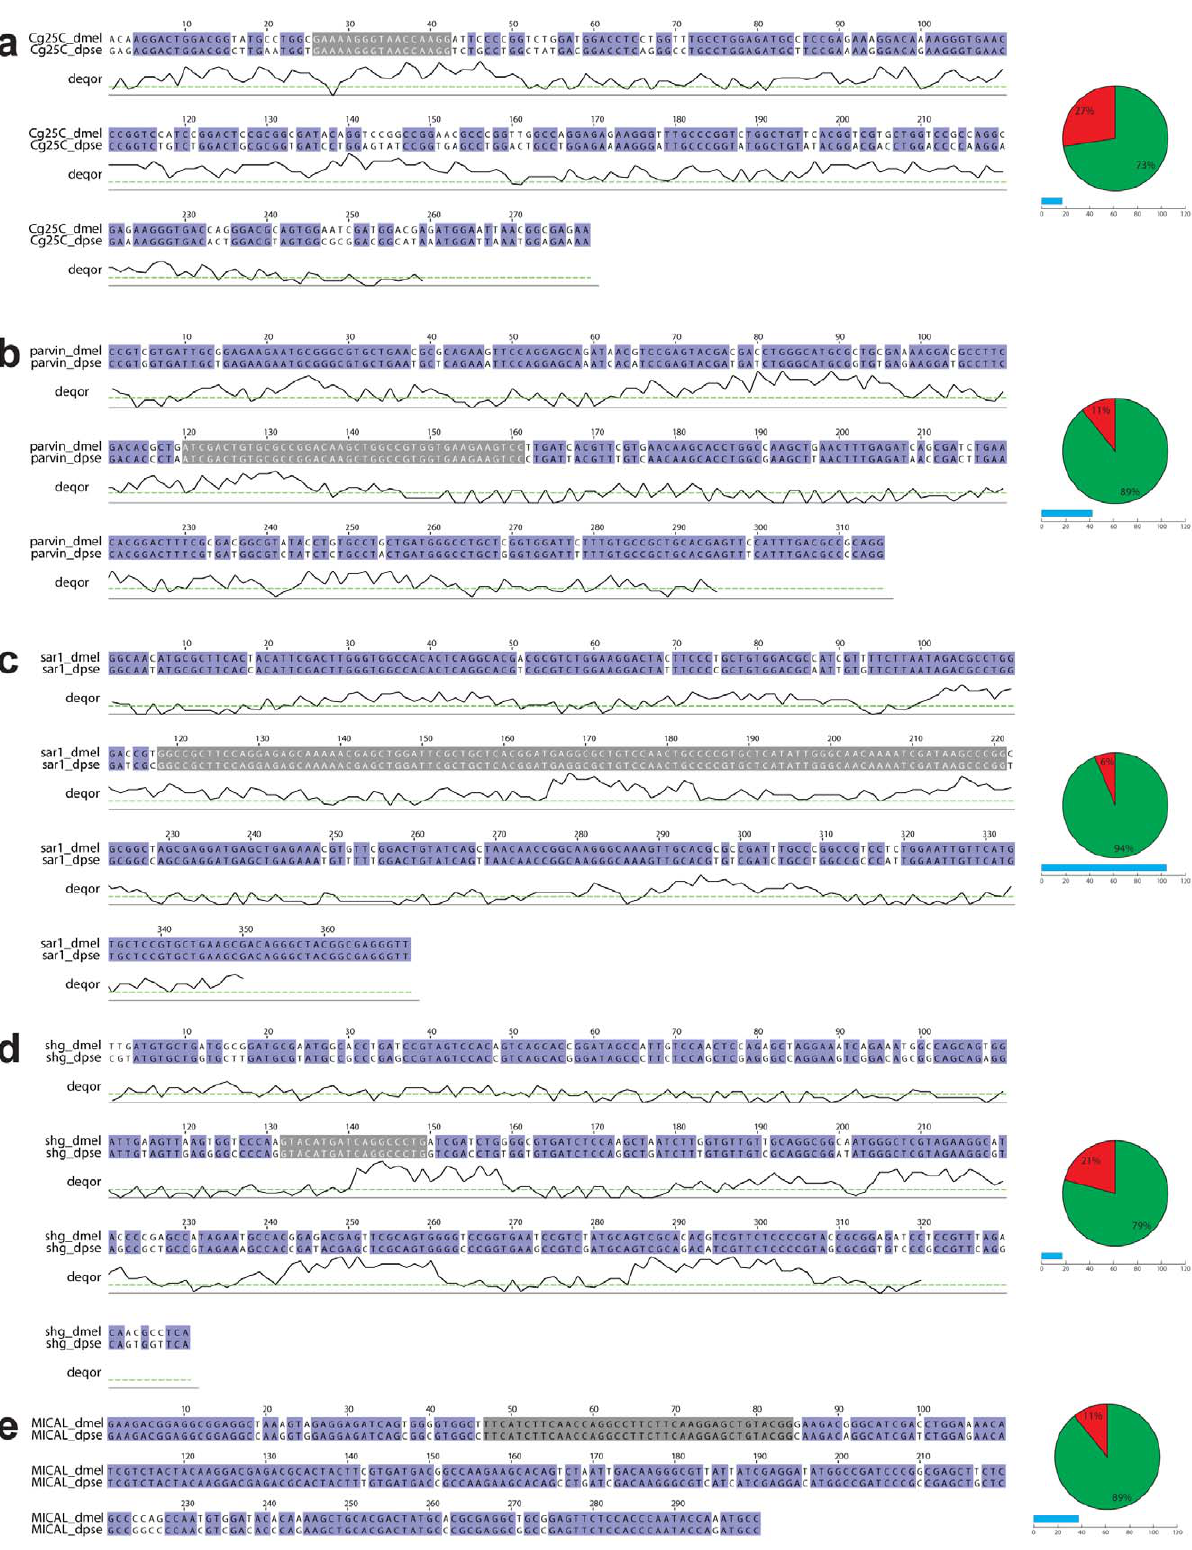
PLoS ONE | www.plosone.org